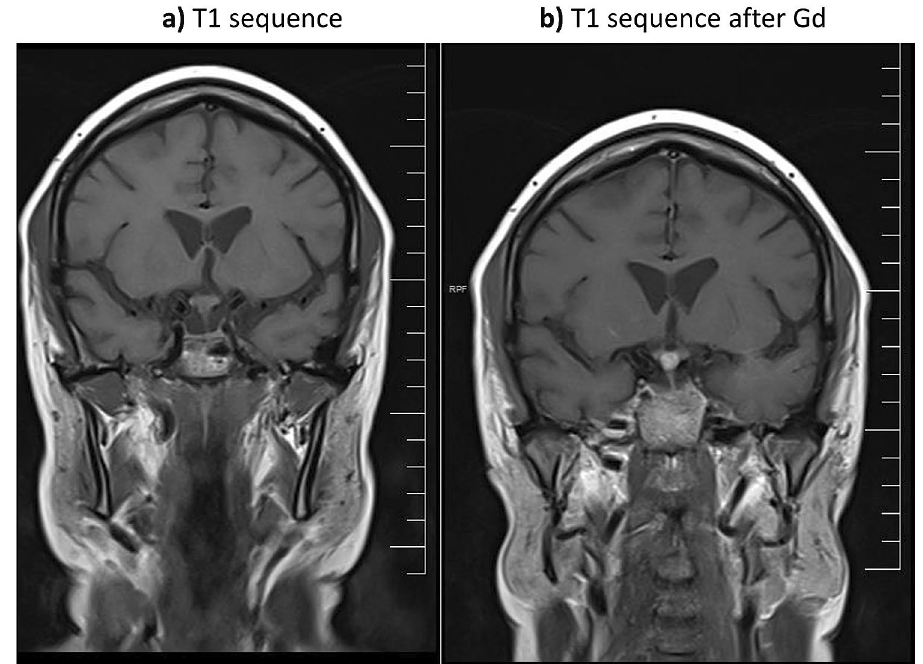
Figure 3. Involvement of optic chiasm and hypophysis; ( a ) T1 sequence; ( b ) T1 sequence after